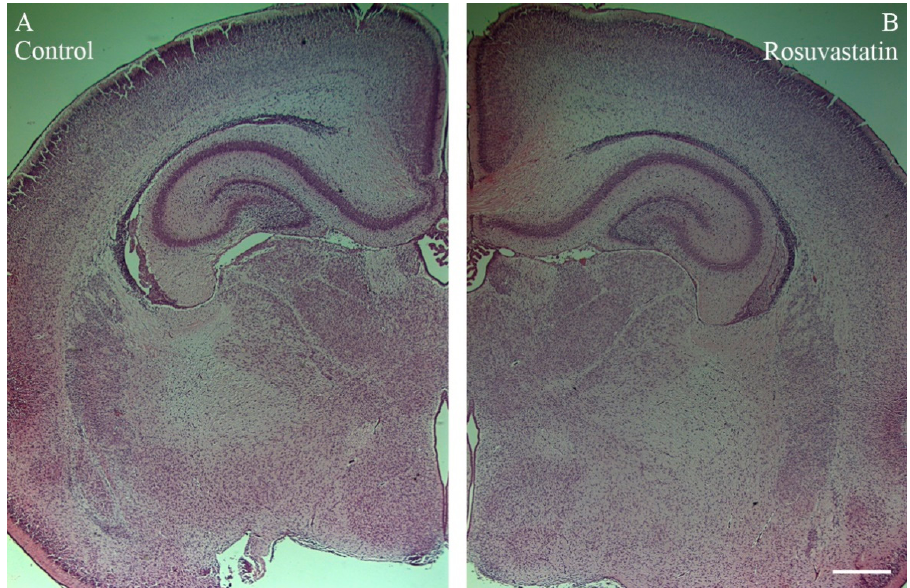
Figure 2. Histological architecture of the newborn rat brain. No differences were observed in paraffin-embedded, H&E-stained tissue sections of control ( A ) and rosuvastatin (RST)-treated newborn ( B ) brains by light microscopy. Scale bar: 1 mm.